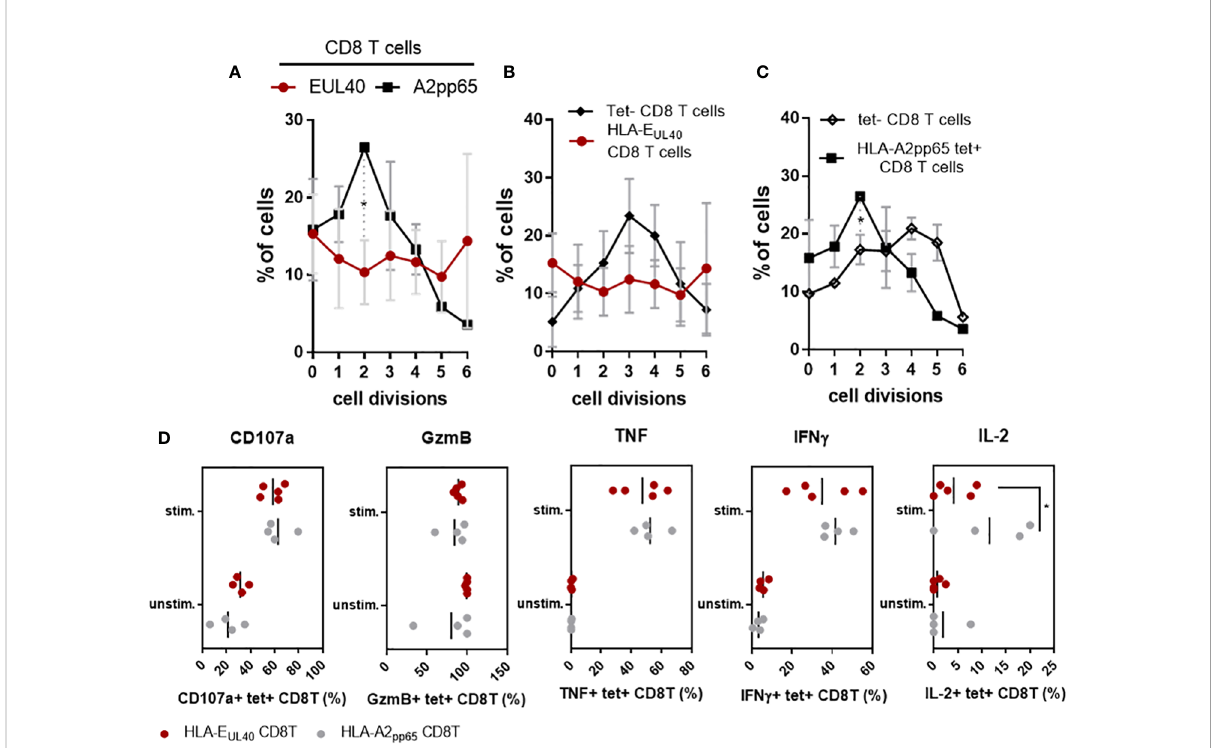
FIGURE 5 Proliferation and effector capacities for HLA-E UL40 versus HLA-A2 pp65 CD8T cells. PBMC from HCMV + HV possessing either HLA-A2 pp65 (n=4) or HLA-E UL40 (n=5) CD8T cell responses were used. (A – C) For proliferation assays, PBMC were loaded with Cell Proliferation Dye and cultured for 4 days on culture plates either uncoated or coated with anti-CD3 and anti-CD8 mAbs before immunostaining. The number of cell division was quanti fi ed using Flowjo ® after gating on live CD3 + gd TCR - CD8 + tetramer positive (tet+) HLA-E UL40 or HLA-A2 pp65 and tetramer negative (tet-) T cell populations. Analyses comparing cell division for HLA-E UL40 and HLA-A2 pp65 CD8T cell populations (A) , HLA-E UL40 and tet - CD8T cell populations (B) and HLA-A2 pp65 and tet - CD8T cell populations (C) are shown. Data are expressed as percentages of cells in the cycles. (D) Level of membrane CD107a, granzyme B (GzmB) expression and intracellular TNF, IFN g and IL-2 expressed by HLA-E UL40 and HLA-A2 pp65 CD8T cell populations before (unstim) and after (stim) a 4h-stimulation assay in the presence of PMA/ionomycin. Each point represents an independant CD8T cell response. Data are expressed as percents of positive cells among tet + CD8T cells. Statistical analysis was performed by Mann-Whitney U -test. P values: *for p <